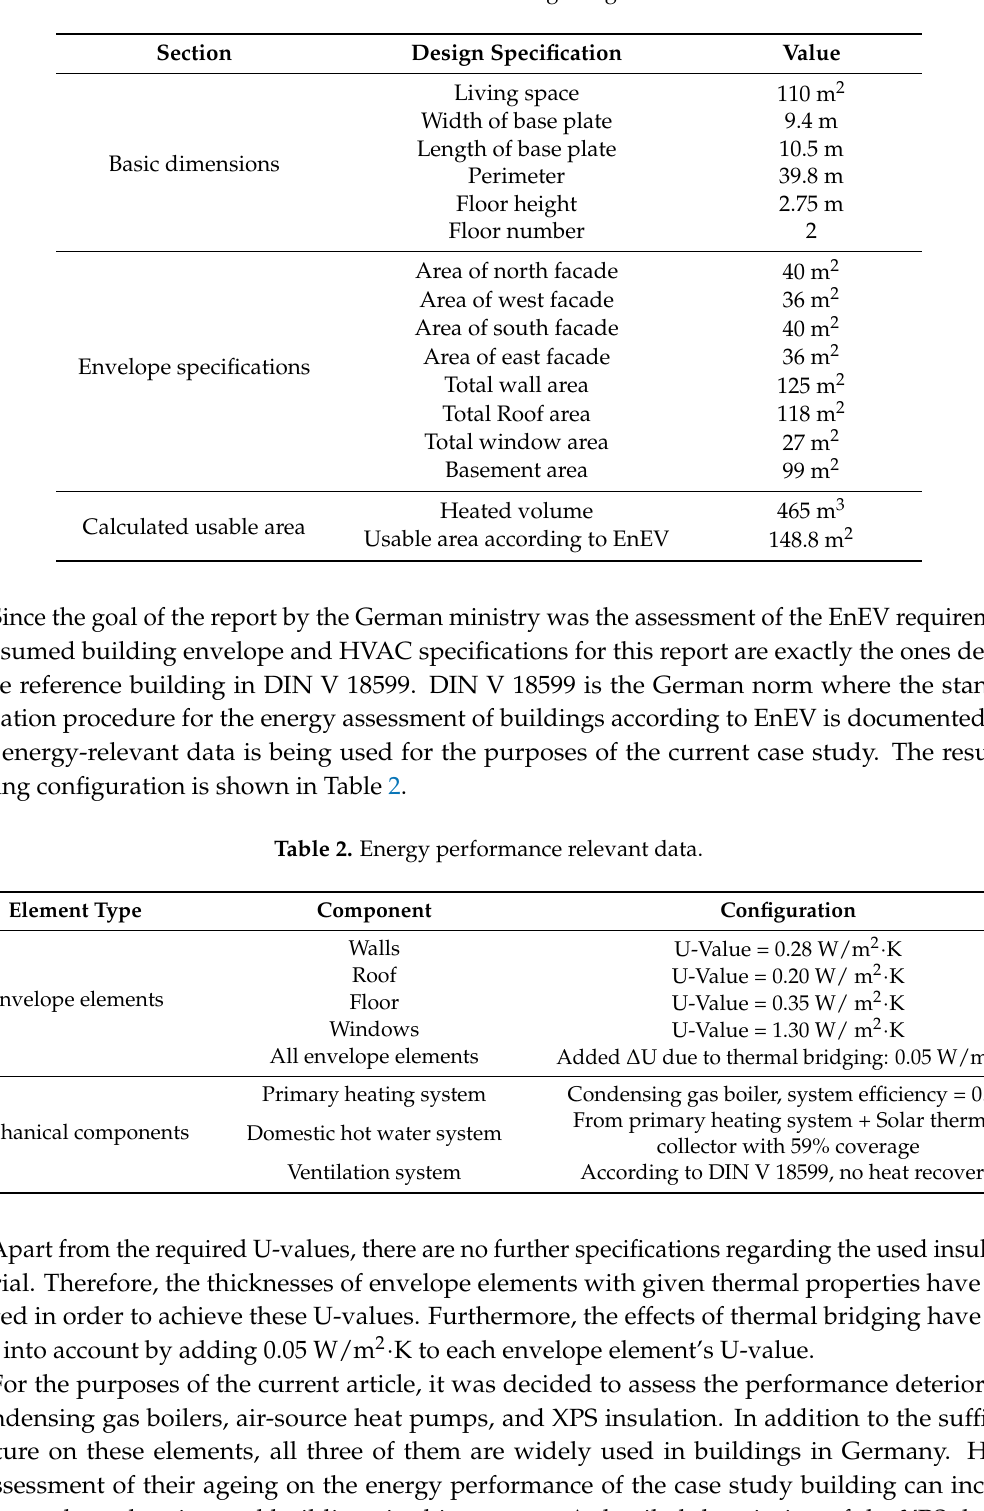
Table 1. Assessed building design data.